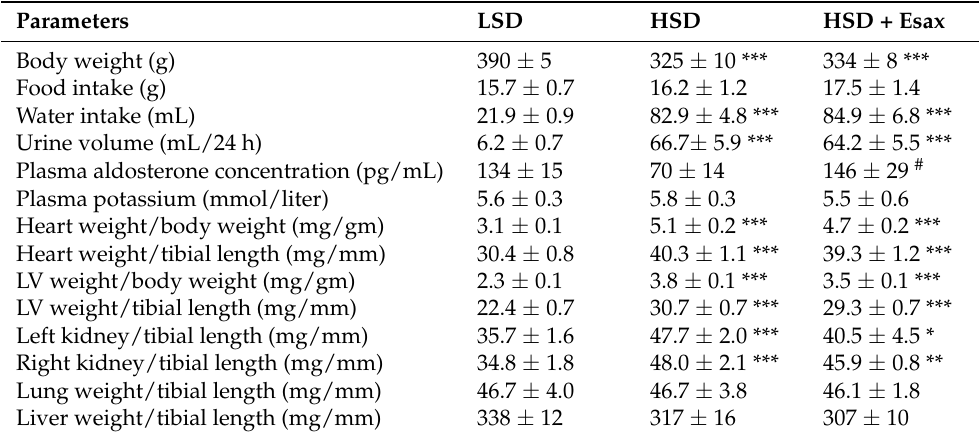
Table 1. Effects of esaxerenone on the parameters measured in DSS rats at 16 weeks of age.